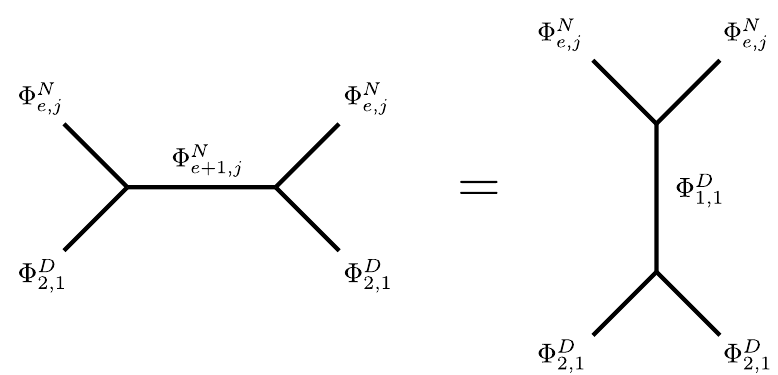
Φ N Φ N Φ D i . Notice the appear- 2 , 1 2 , 1 e,j e,j = 1 , due to the −